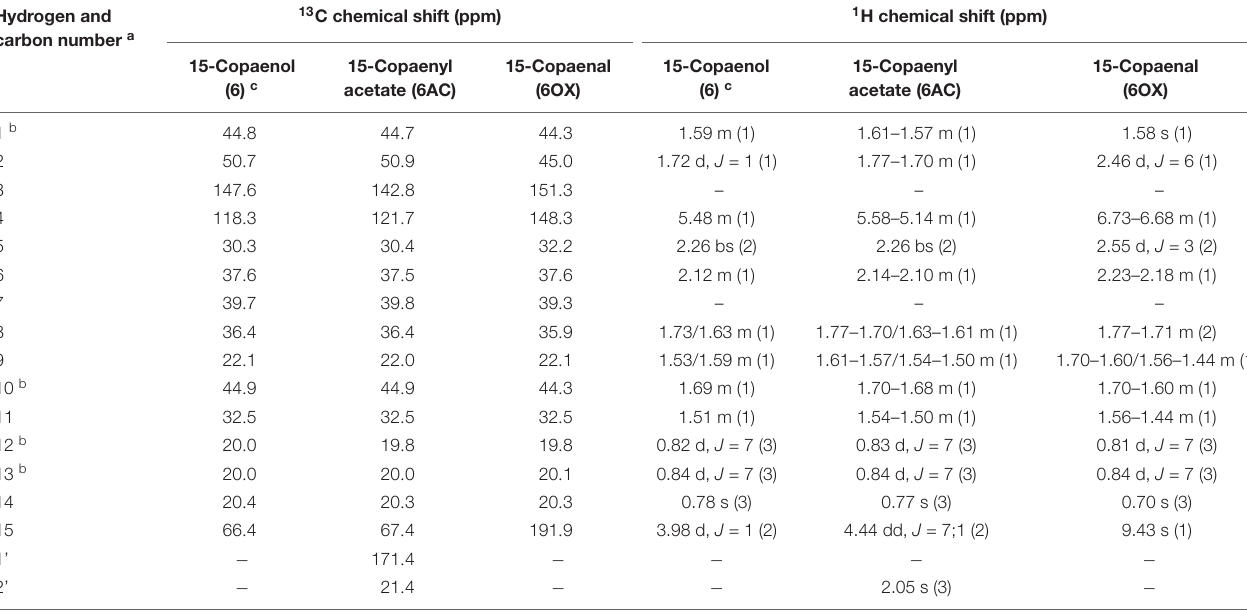
TABLE 1 | 13 C (100 MHz, CDCl 3 ) and 1 H-NMR (400 MHz, CDCl 3 ) data of 15-copaenol, 15-copaenyl acetate, and 15-copaenal. Hydrogen and carbon number